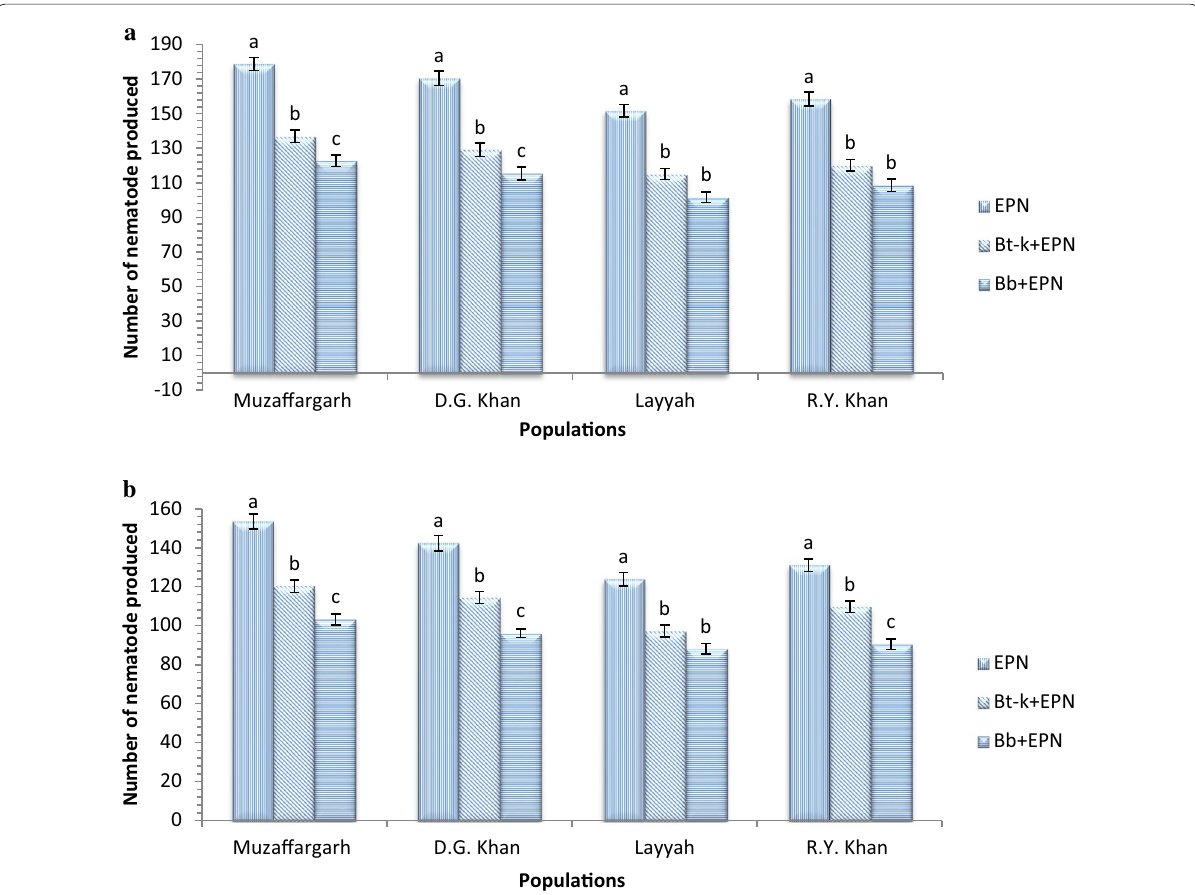
Fig. 4 a Nematode production (IJs ml − 1 ) in larvae of Rhynchophorus ferrugineus treated with Bt-k (70 µg g − 1 ), Beauveria bassiana (1 ml − 1 ) and Heterorhabditis bacteriophora (300 IJs ml − 1 ) applied alone or in combination. Treatments followed by the same letter within each treatment are not significantly different; HSD test P 0.05 ( Bt-k : Bacillus thuringiensis var. kurstaki , Bb: Beauveria bassiana , EPN: Heterorhabditis ≤ bacteriophora ). b Nematode production (IJs ml − 1 ) in adults of Rhynchophorus ferrugineus treated with Bt-k (70 µg g − 1 ), Beauveria bassiana (1 conidia ml − 1 ) and Heterorhabditis bacteriophora (300 IJs ml − 1 ) applied alone or in combination. Treatments followed by the same letter within each treatment are not significantly different; HSD test P 0.05 ( Bt-k : Bacillus thuringiensis var. kurstaki , Bb: Beauveria bassiana , EPN: Heterorhabditis ≤ bacteriophora